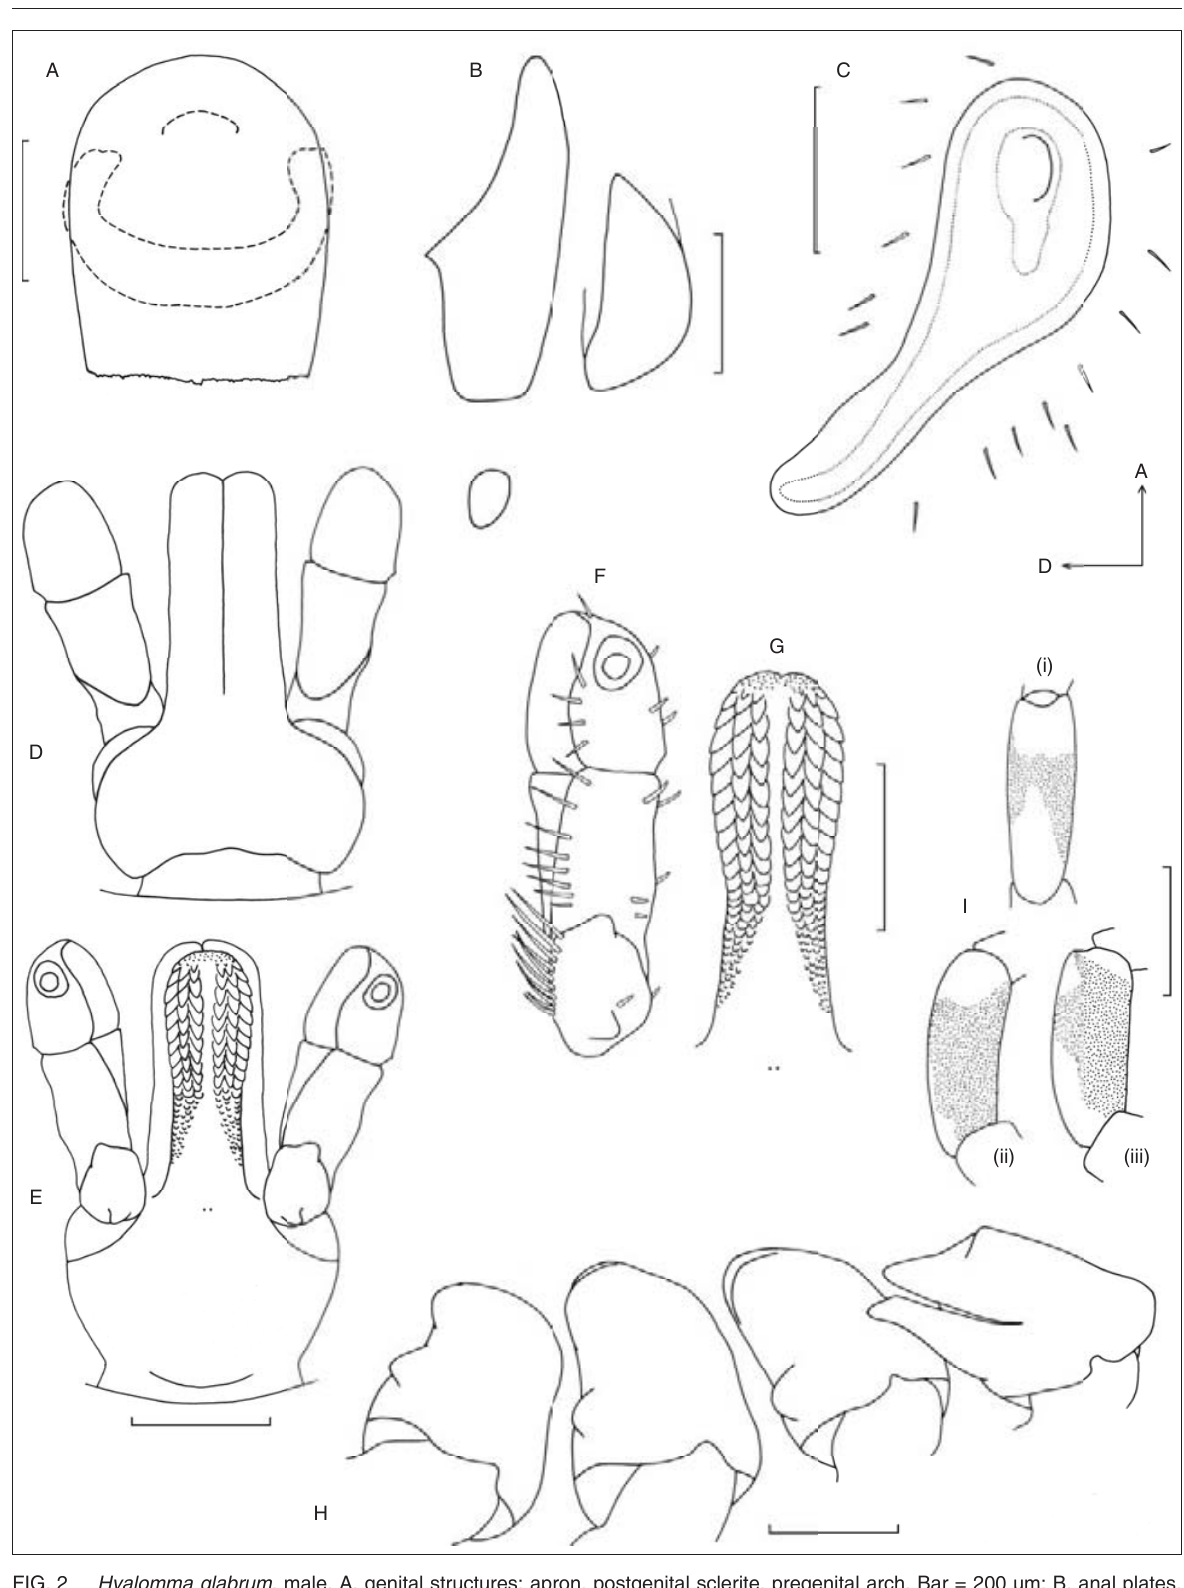
FIG. 2 Hyalomma glabrum , male, A, genital structures: apron, postgenital sclerite, pregenital arch. Bar = 200 μ m; B, anal plates. Bar = 500 μ m; C, spiracular plate and circumspiracular setae (A—anterior; D—dorsal). Bar = 400 μ m; D, gnathosoma dor- sally. Bar = 500 μ m; E, gnathosoma ventrally. Bar = 500 μ m; F, palp ventrally. Bar = 400 μ m; G, hypostome. Bar = 400 μ m; H, coxae. Bar = 500 μ m; I, genu IV: (i), dorsal view, (ii), medial view, (iii), lateral view. Bar =